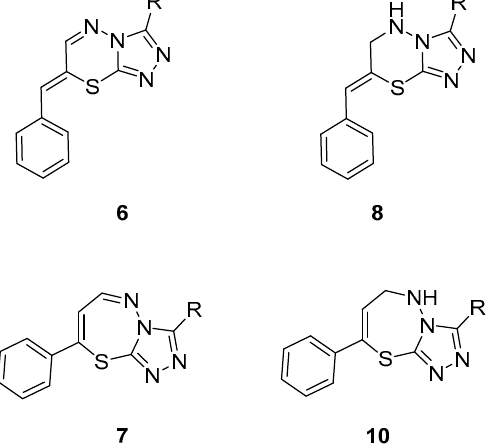
Figure 2. Target compounds: 3-substituted ( Z )-7-benzylidene-7 H -[1,2,4]triazolo[3,4- b ][1,3,4]thiadiazines 6 , 3-substituted ( Z )-7-benzylidene-6,7-dihydro-5 H -[1,2,4]triazolo[3,4- b ][1,3,4]thiadiazines 8 , 3-substituted 8-phenyl-[1,2,4]triazolo[3,4- b ][1,3,4]thiadiazepines 7 and 3-substituted 8-phenyl-5,6- dihydro-[1,2,4]triazolo[3,4- b ][1,3,4]thiadiazepines 10 .